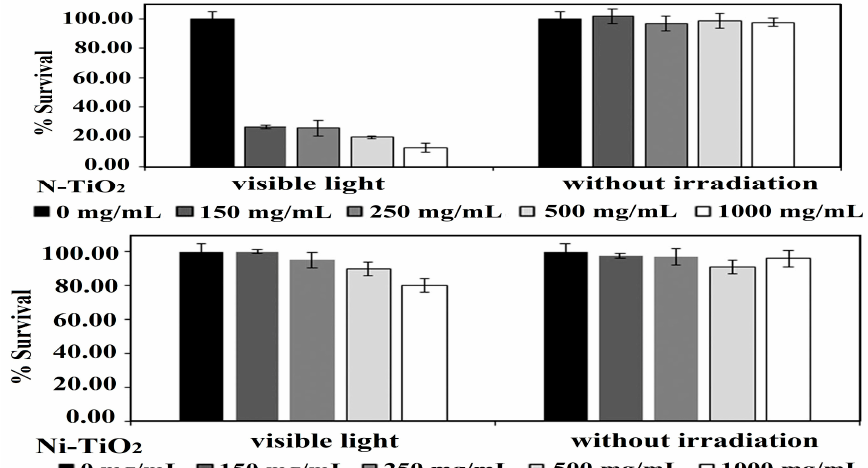
Figure 23. Photocatalytic inactivation of S. aureus with N- and Ni-doped TiO 2 NPs of different contents under visible light. Statistically significant at p < 0.05. Reproduced with permission from [161]. Copyright Springer, 2016.